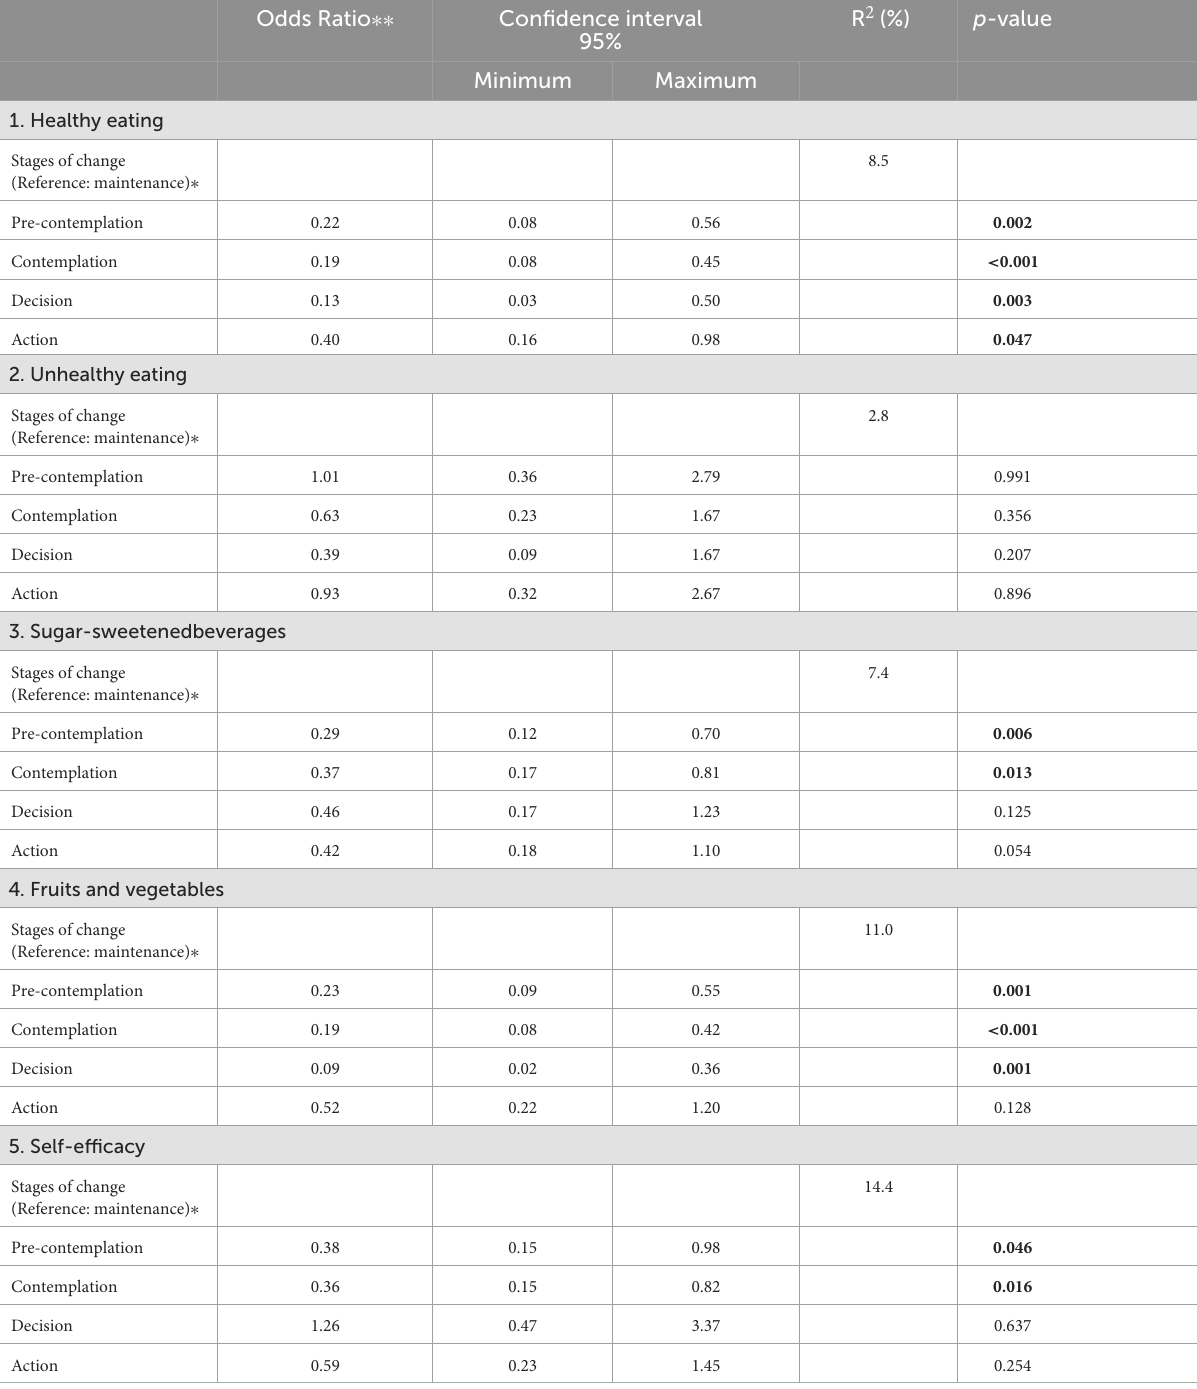
TABLE 2 Association between consumption of food markers and self-efficacy (outcomes) with stages of change (independent variable) among Brazilian adolescents and young adults. R 2 (%) p -value Odds Ratio ∗∗ Confidence interval 95% Minimum